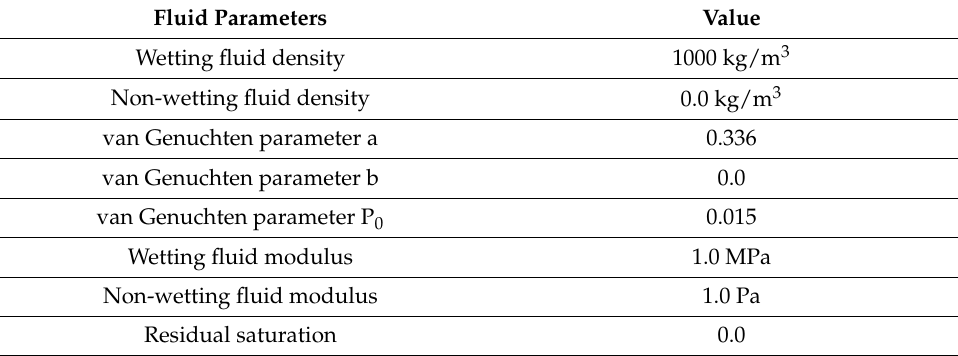
Table 4. Fluid (water) properties for